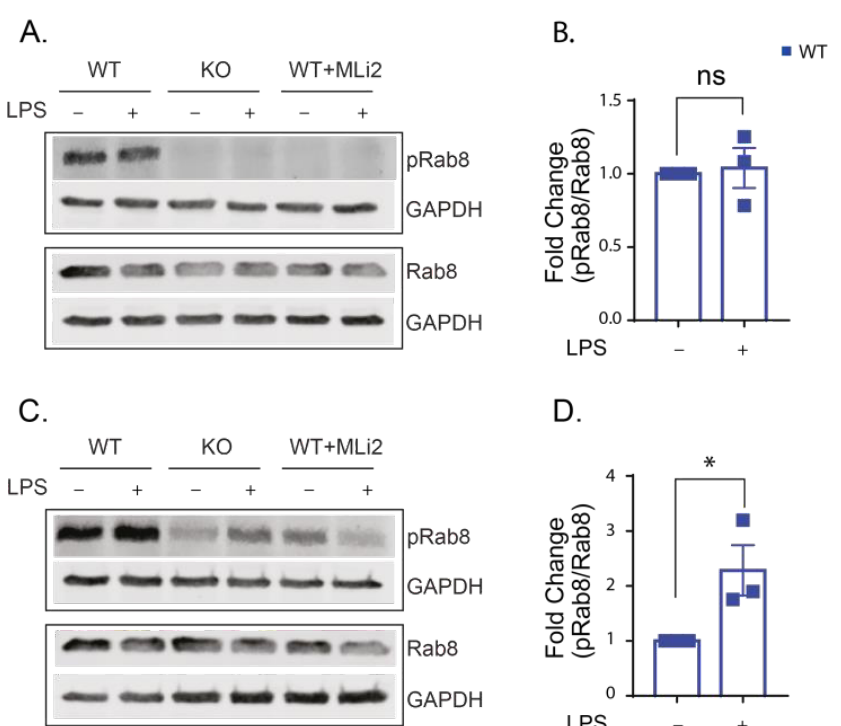
Figure 1. LPS stimulation for 24 h increases LRRK2 kinase activity. ( A , C ) Representative Western blots for lysates from WT-, KO- and MLi2-treated WT cells with and without LPS stimulation for 6 ( A ) and 24 ( C ) hours and immunoblotted with Rab8, phospho Rab8 and glyceraldehyde-3-phosphate dehydrogenase (GAPDH) antibodies (GAPDH is used as a loading control). LRRK2 kinase activity was calculated from the ratio of phospho Rab8/Rab8. ( B ) Fold change in phospho Rab8/Rab8 relative to the WT was calculated for 6 h LPS stimulation and ( D ) 24 h LPS stimulation. The experiment was performed 3 times and t-test was used to compare the ratio of phospho Rab8/Rab8 relative to the WT. Error bar represents mean ± SEM. p -values indicating statistically significant differences between the mean values are defined as follows: ns — not significant, * p < 0.05.